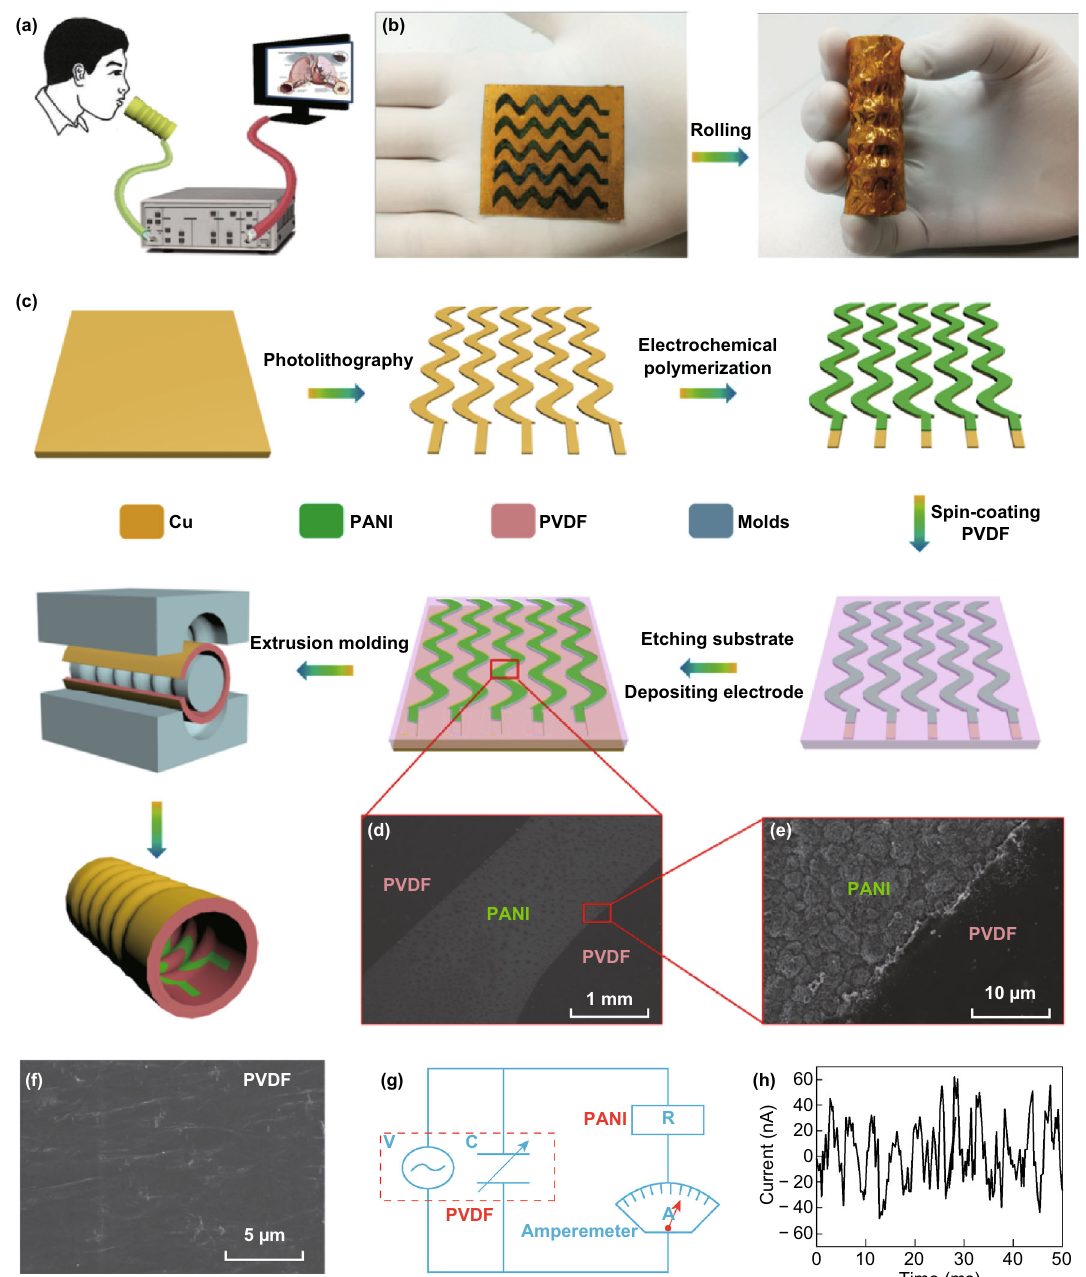
Fig. 1 Structure and fabrication of the device. a Proposed concept. b Photographs of un-rolled PANI/PVDF film and as-fabricated bellows. c Fabrication process of the device. d SEM image of PANI/PVDF. e High-magnification SEM image of PANI/PVDF interface. f SEM image of PVDF film. g Lumped parameter equivalent circuit model of the device. h A few cycles of the output